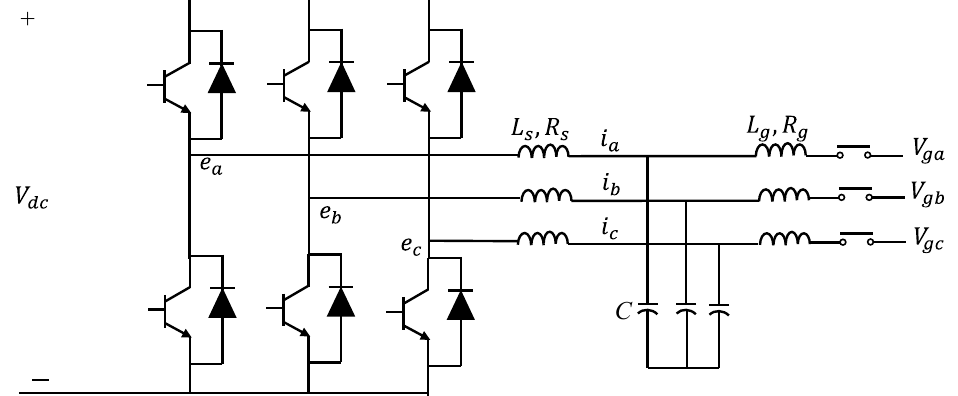
Figure 6. Power stage component of a synchronverter [26].